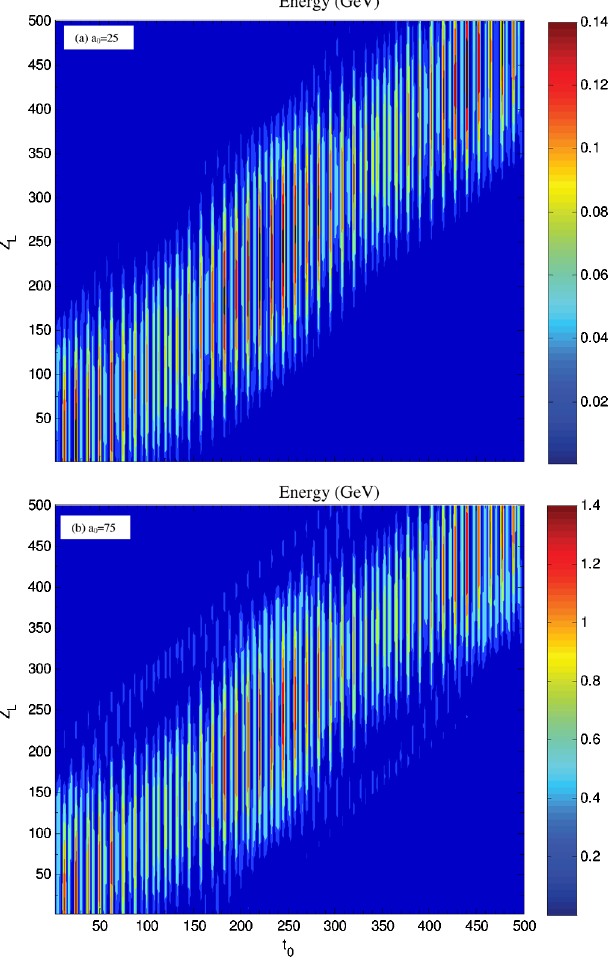
FIG. 8. Electron energy (in GeV) distribution as a function of normalized z 0 and r i for (a) a 0 ¼ 25 , and (b) a 0 ¼ 75 . Other parameters are t 0 ¼ 0 , z L ¼ 0 , r 0 ¼ a 0 , (cid:3) ¼ 200 , and (cid:2) ’ 0 ¼